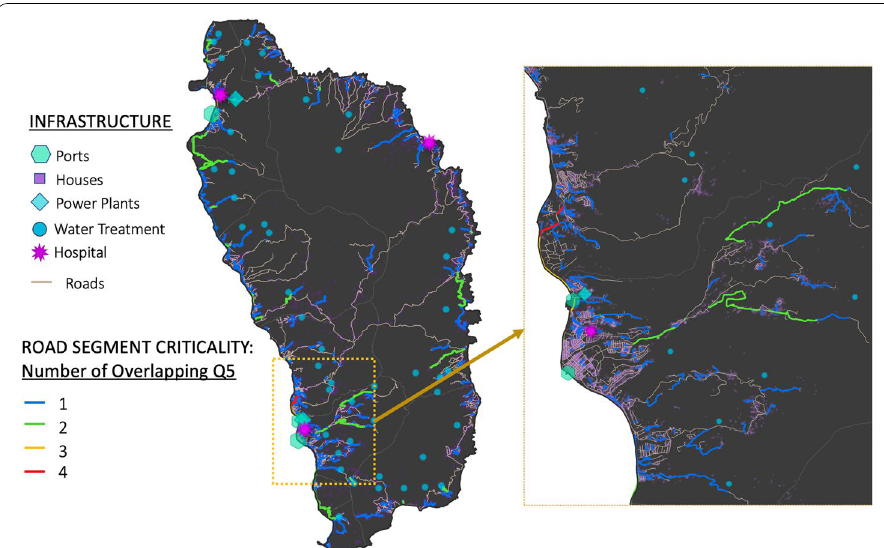
Fig. 3 Assessment of service delivery interdependencies, calculated as the number of road segment service delivery perspectives considered highly critical (Q5) that intersect within the network. Based on the four individual supply routes analyzed (seaports to power plants, seaports to hospitals, water treatment facilities to hospitals and homes to hospitals), this figure shows locations where a road segment is identified as most critical (Q5) for at least one service. Locations where critical segments intersect identify the most critical segments as multiple services rely on their operation. Roads in green indicate that the segment is Q5 for two services, while orange segments are Q5 for three services. A very small number of road segments are Q5 for all four services, but these roads indicate that failure affects the delivery of all four services if perturbed